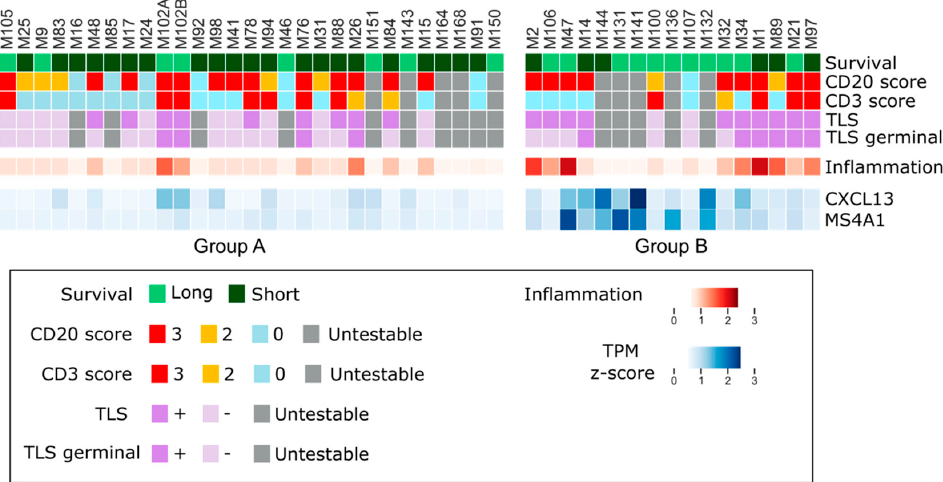
Figure 3. Immunostaining and transcriptomic overlap. From the top downwards: the two groups of the ePM, A and B, are reported—long survivors in light green and short survivors in dark green. CD20 and CD3 scores as in the legend. TLS and TLS germinal as in the legend. Untestable cases are indicated in grey. Inflammation percentage is reported in normalized z-score. CXCL13 and MS4A1 are reported with their TPM z-score.